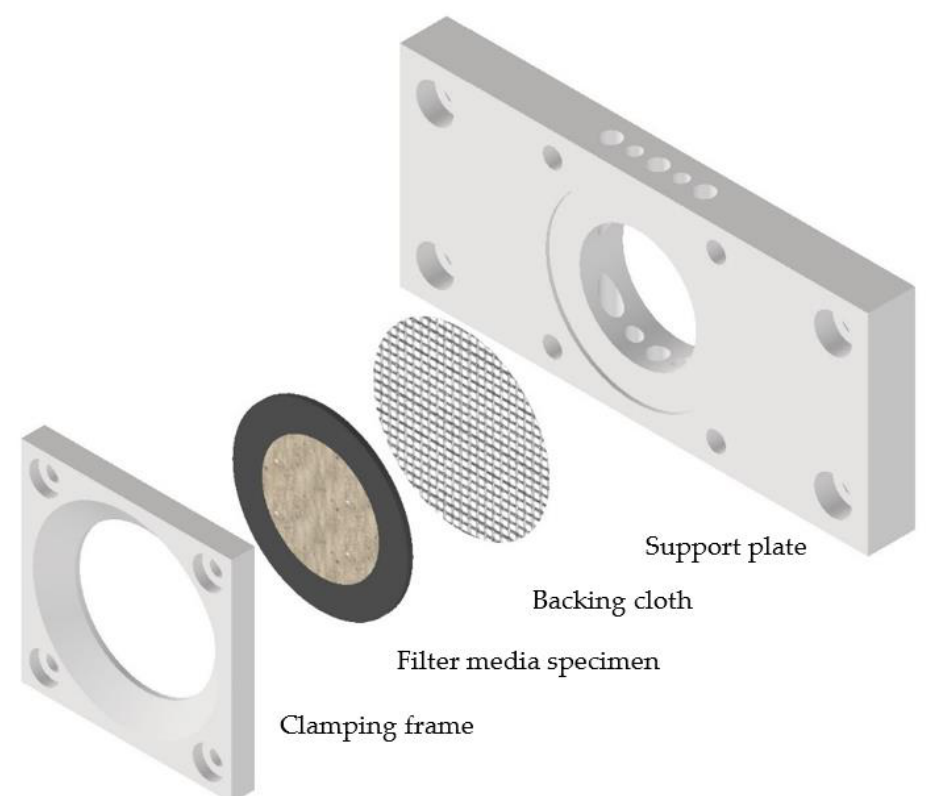
Figure 3. Design of the sample holder of the nozzle test station consisting of a support plate onto which the filter media sample and a backing cloth are fixed with a clamping frame.